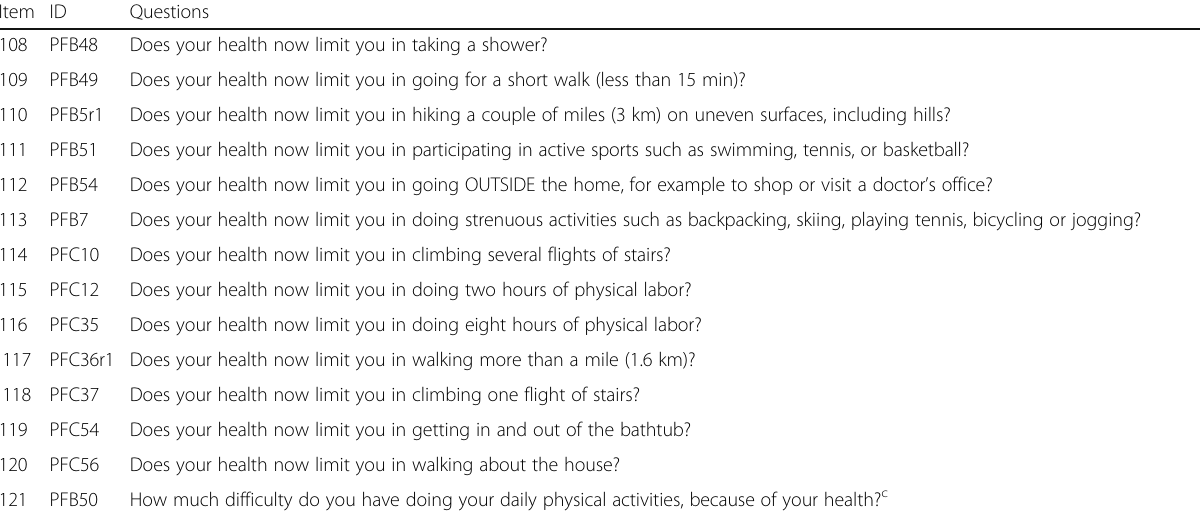
Table 5 PROMIS v1.2 Physical Function item bank (Continued)